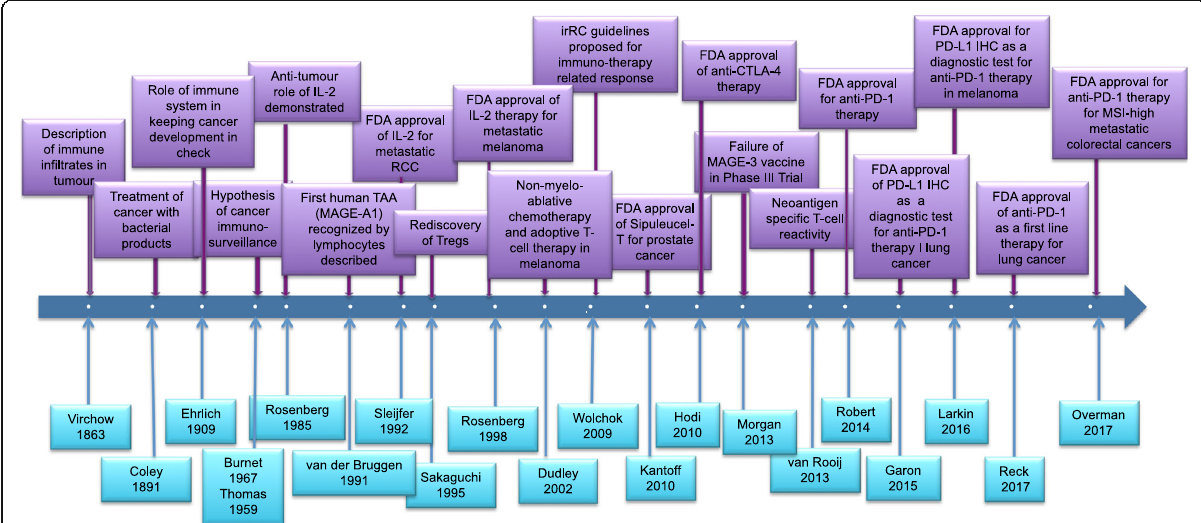
Fig. 1 Timeline figure showing the milestones in the history and development of cancer immunotherapies. FDA (Food and Drug Association); IL-2 (Interleukin 2); PD-1 (Programmed Death receptor-1); PD-L1 (Programmed Death receptor Ligand-1); IHC (Immunohistochemistry). CTLA-4 (Cytotoxic T-lymphocyte associated protein-4); MSI-high (microsatellite instable-high) Additional file